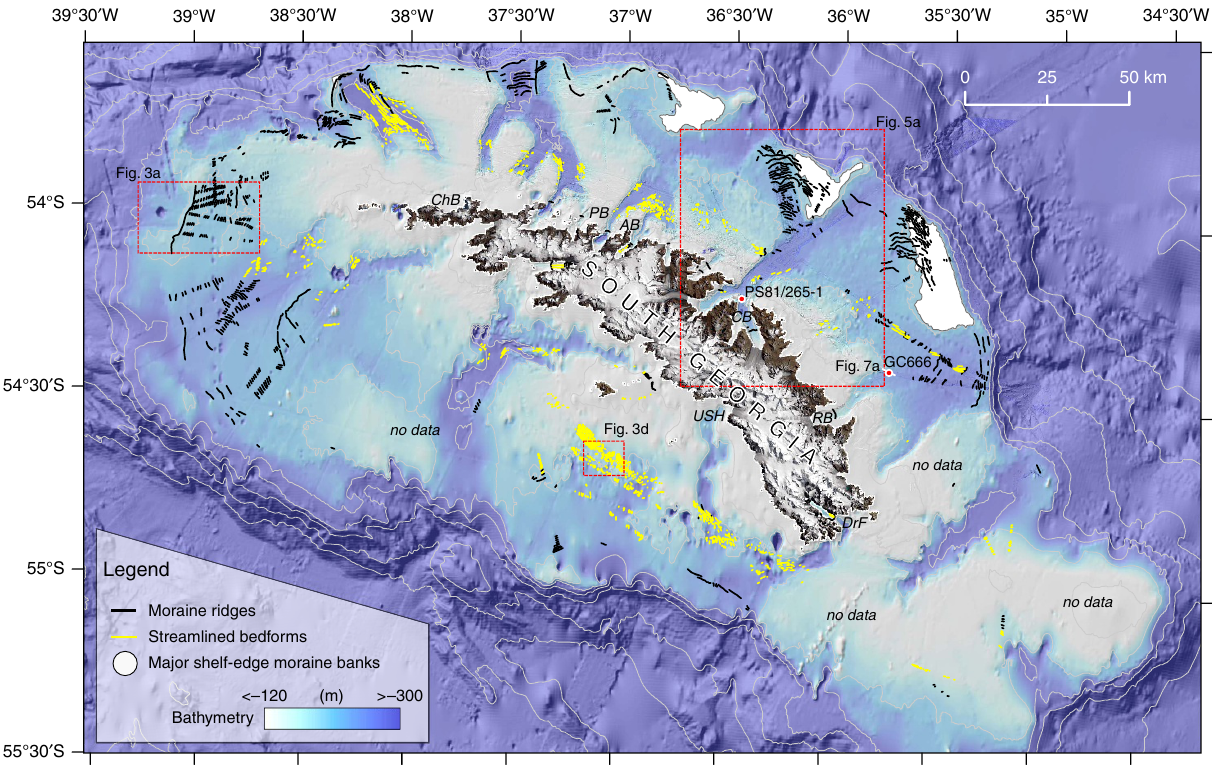
Figure 2 | Overview of sea-floor landforms mapped in this study. Bathymetry of the South Georgia continental block (ref. 22), with newly mapped moraine ridges (black), streamlined bedforms (yellow) and moraine banks (light grey) depicting the imprint of an entire sub-polar palaeo-ice cap. Locations of subsequent figures shown by red boxes. ChB: Church Bay, PB: Possession Bay, AB: Antarctic Bay, CB: Cumberland Bay, RB: Royal Bay, DrF: Drygalski Fjord, USH: Undine South